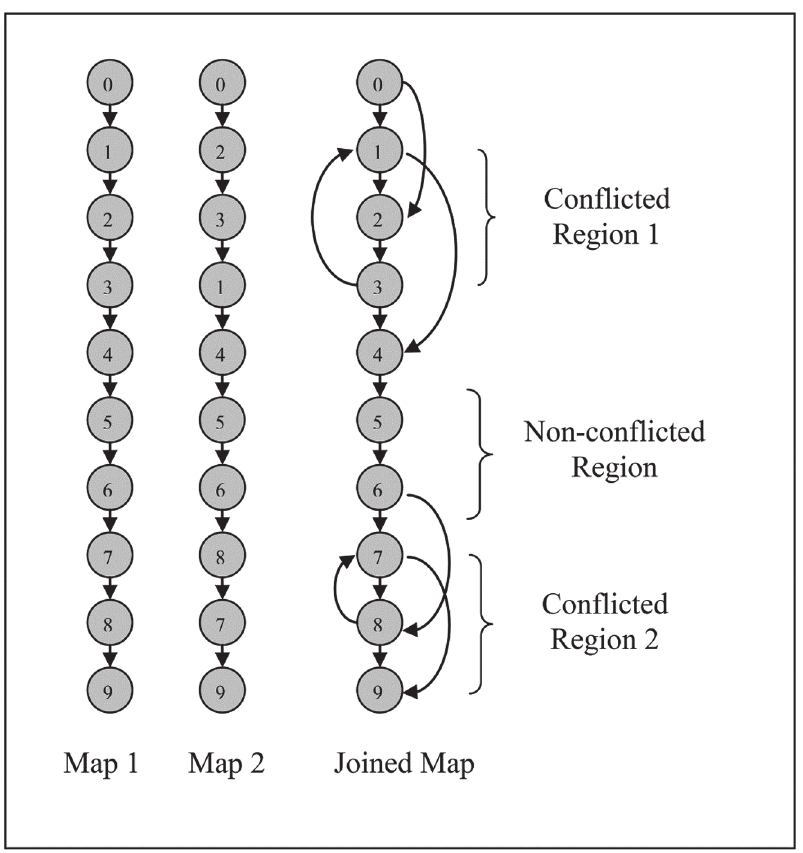
Fig 1. Representing a set of two individual maps as a directed acyclic graph (DAG). Two single maps (map1 and map2) are joined as a DAG. The joint map contains two conflicted regions.